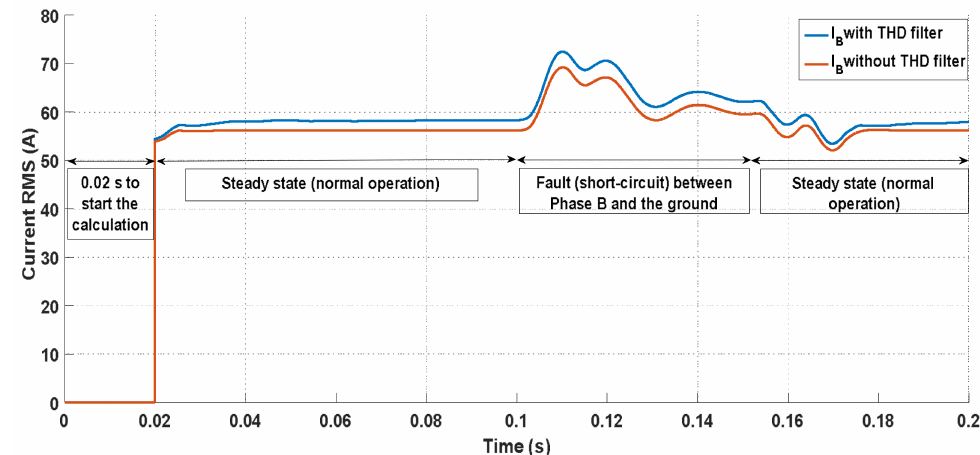
Figure 16. Compare rms current calculation using THD filter & without THD filter.